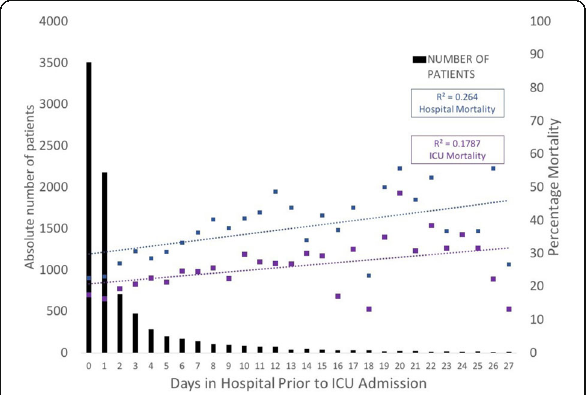
Fig. 1 (abstract 000128). Graph showing number of patients admitted to the ICU (days 0-28) on primary y-axis. Graph showing percentage hospital mortality and percentage ICU mortality with respect to number of days in hospital prior to ICU admission secondary y-axis